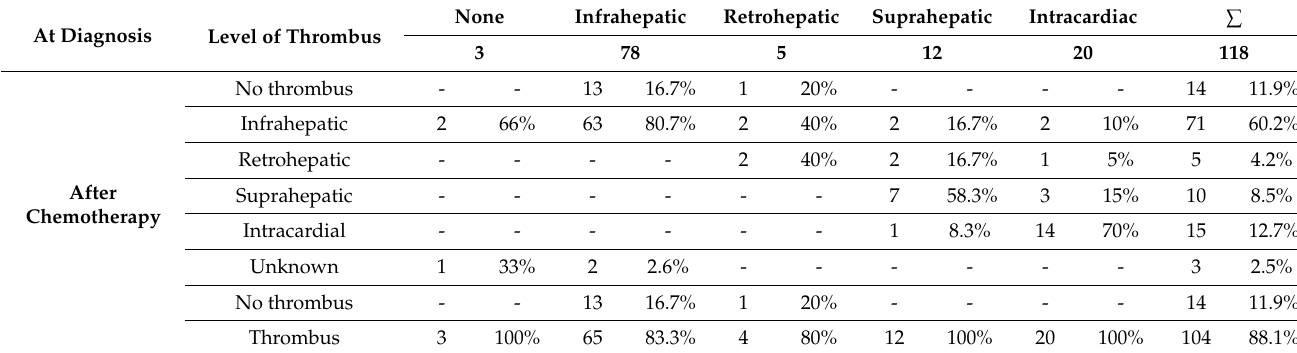
Table 2. Alteration of the thrombus level by chemotherapy ( n = 118). The first row shows the level of thrombus of each group at the time of diagnosis. The second block shows the levels after PC for the individual groups. The third block summarizes the changes.